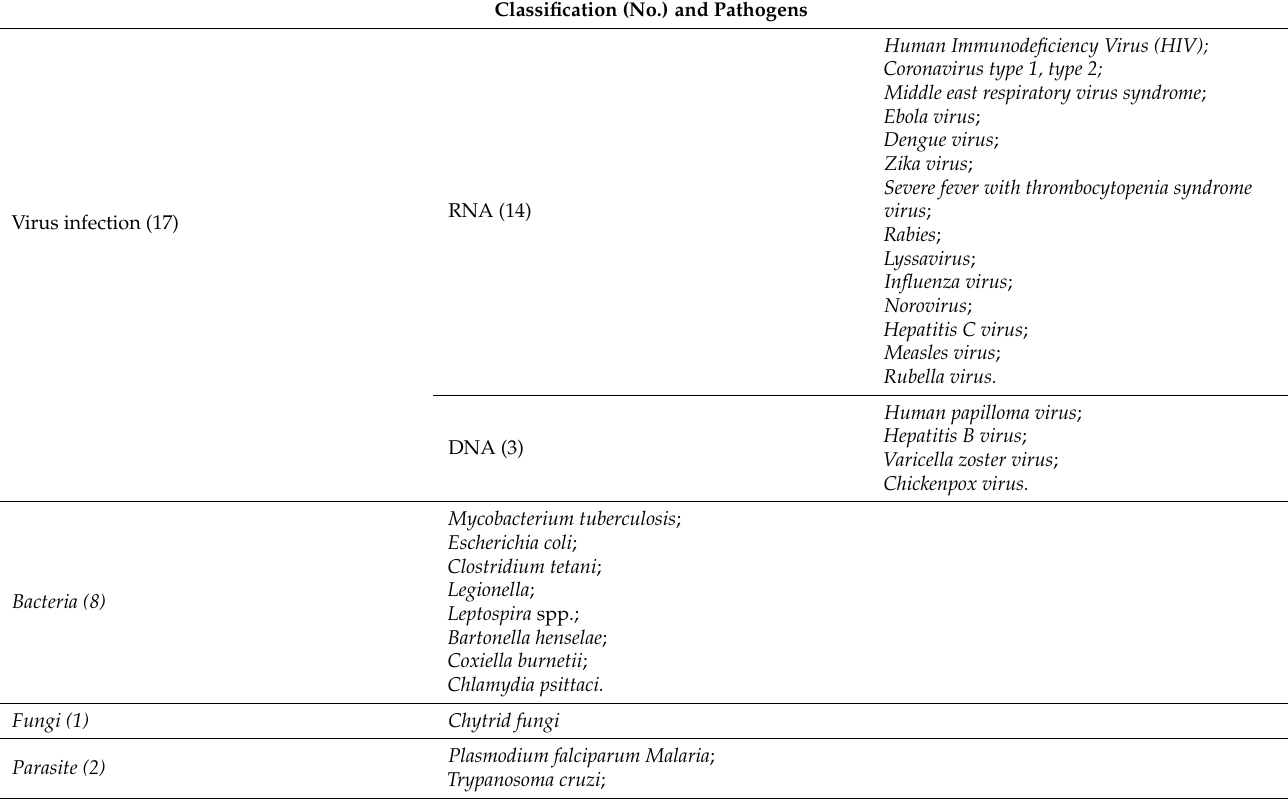
Table 2. Pathogens discussed at the